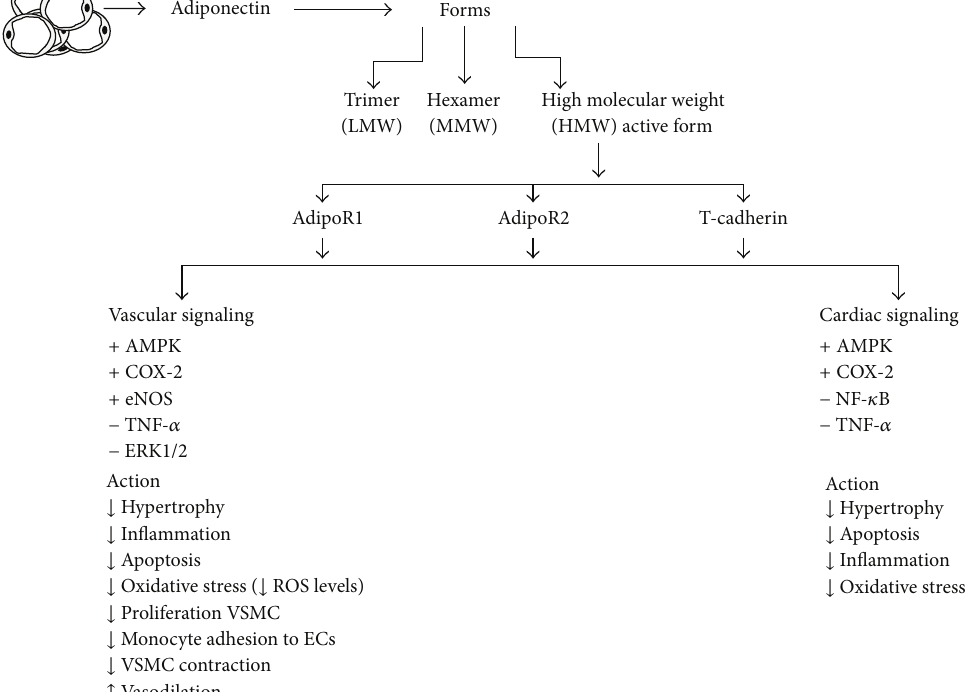
Figure 2: Summary of molecular signaling responses to adiponectin and their cardiac and vascular effect. ↑ or + represents activation of protein or effect whereas ↓ or − indicates inhibition. See text for more